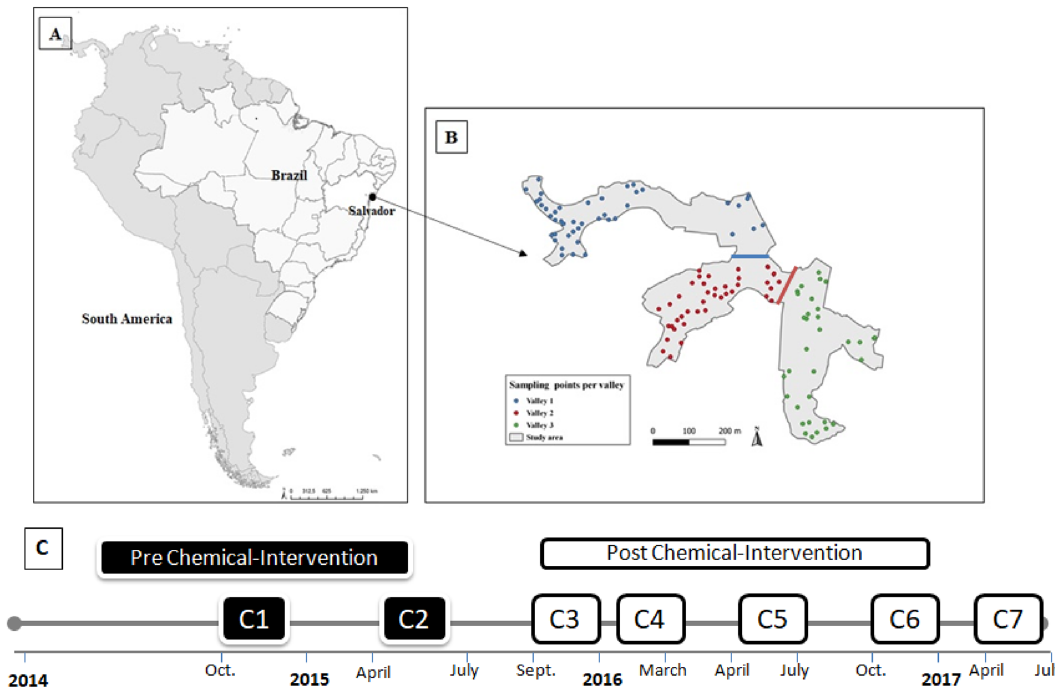
Figure 1. ( A ) Location of Brazil within the map of South America. ( B ) The distribution of the sampling points in the three valleys used in Pau da Lima. The figure ( A , B ) was generated using QGis Version 3.10 software. ( C ) Breakdown of the study timeline for rodent infestation surveys from campaign 1 to